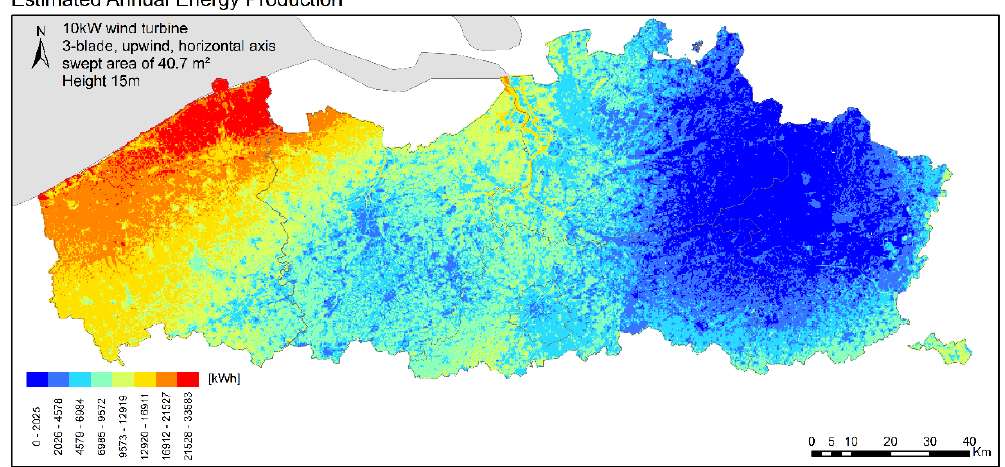
Figure 8. Estimated annual energy production (kWh) for a 10 kW 3-blade, upwind, horizontal axis wind turbine at 15 m height.